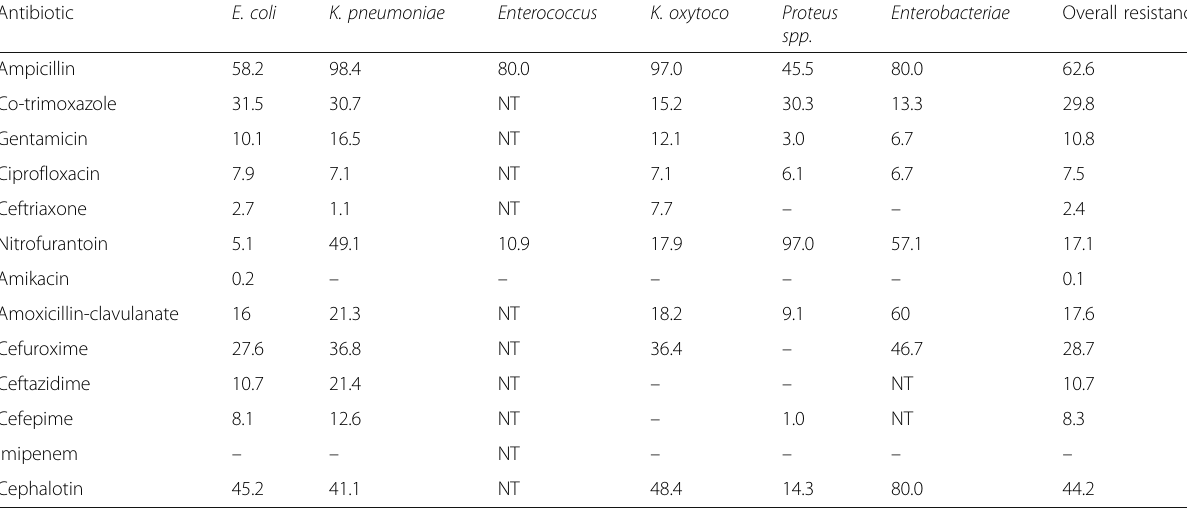
Table 1 Resistance rates (%) of the most frequent urinary tract pathogens against tested antibiotics Antibiotic E. coli